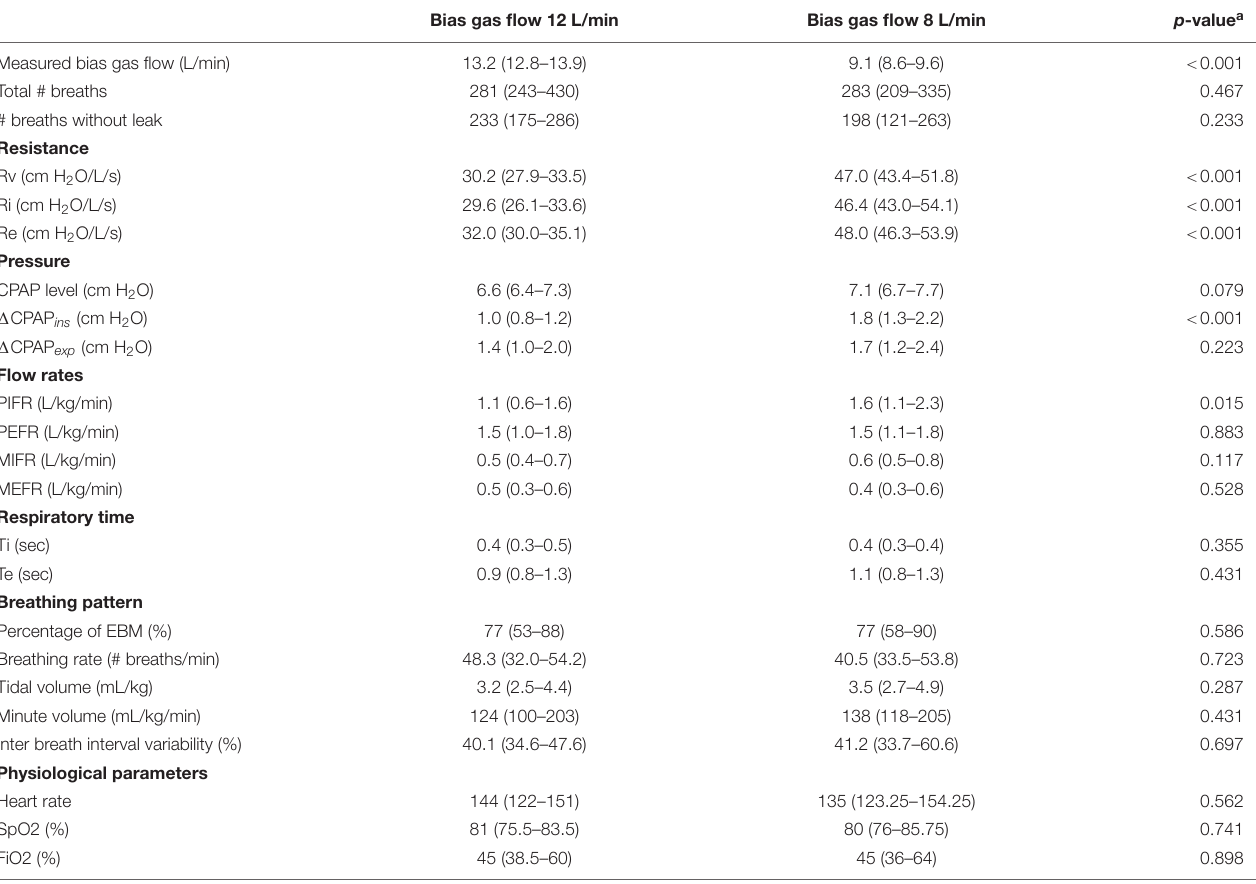
TABLE 2 | Physiological and respiratory parameters during spontaneous breathing on